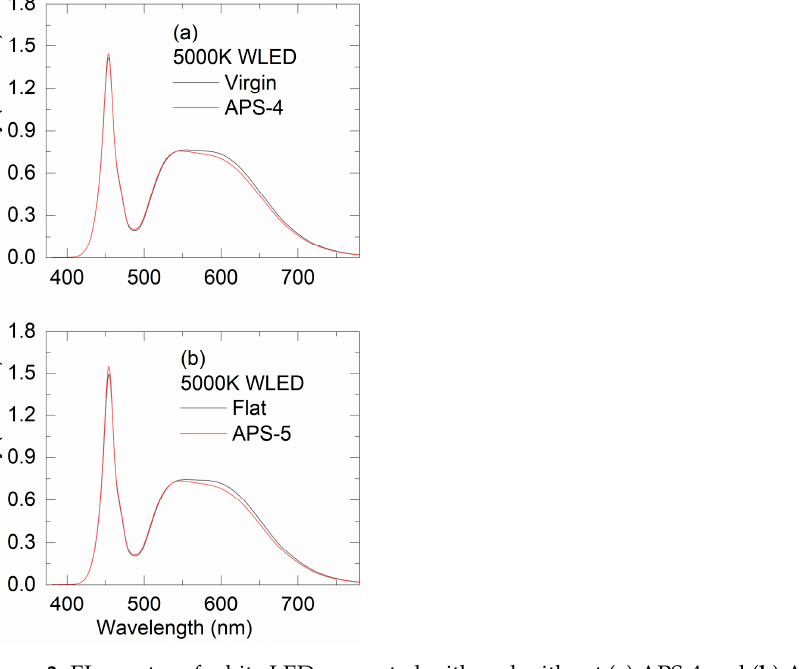
Figure 3. EL spectra of white LEDs mounted with and without ( a ) APS-4 and ( b ) APS-5 at CCTs of 5000 K. The periods of the APSs are about 800